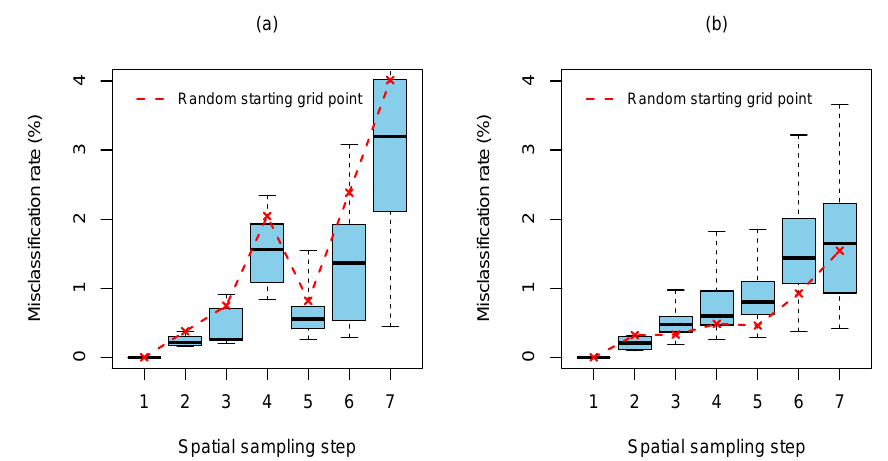
Figure 8. Clustering sensitivity to spatial sampling step and starting grid point through misclassification rates (%) for EM-EII ( ≈ k -means) (a) and EM-VII (b)